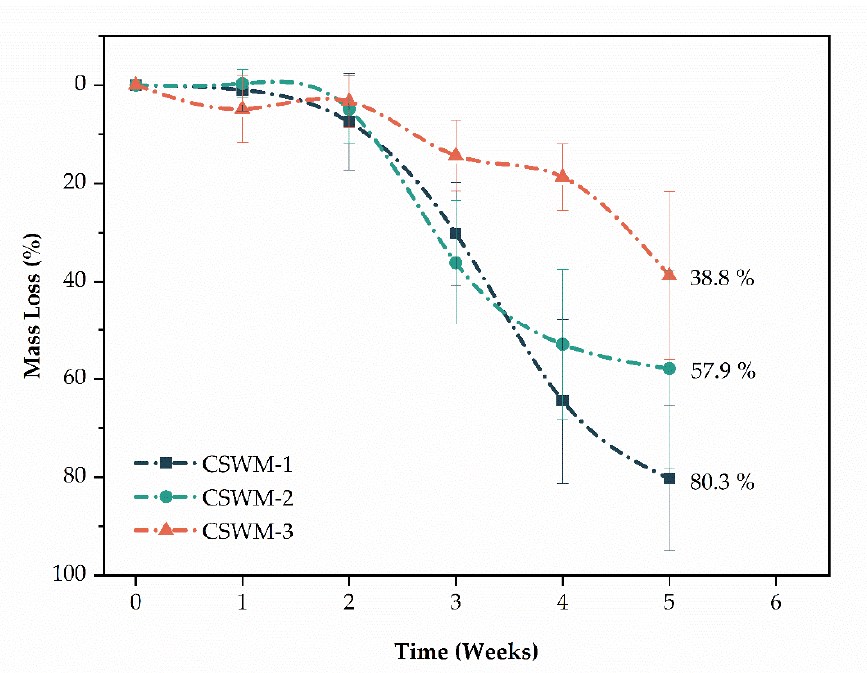
Figure 9. Mass loss of the chitosan woven meshes as a function of the degradation time (mean ± standard deviation).